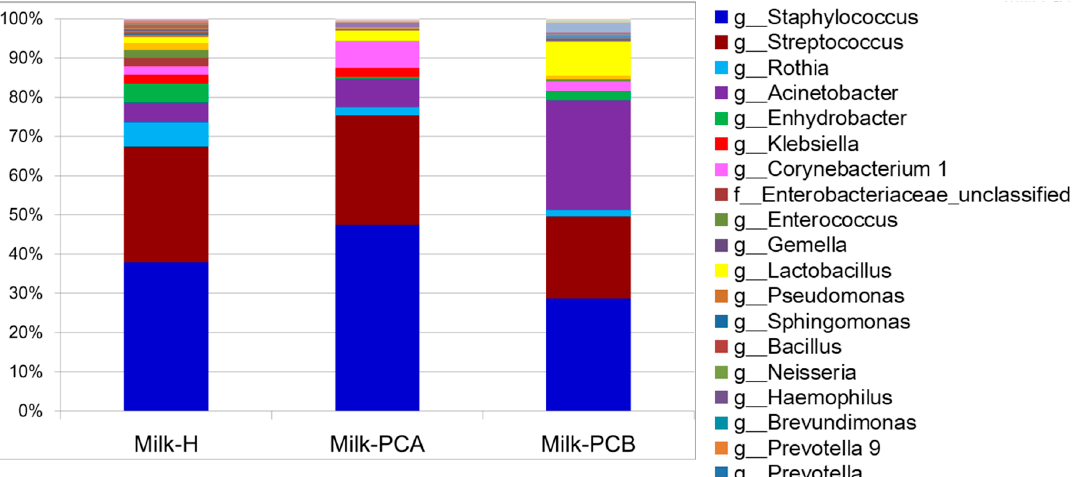
Figure 1. Proportions of major bacterial genus between two “doing-the-month” and one “non-doing- the-month” milk groups. Milk samples were collected from postpartum mothers who had completed the practice of “doing-the-month” (postpartum caring) for 20 to 30 days in postpartum care center A (milk-PCA, n = 14) or B (milk-PCB, n = 27). The control milk samples were harvested from the postpartum mothers in hospital who did not conduct the “doing-the-month” (milk-H, n = 46). The relative abundance of all the bacterial genera in each milk sample was determined using 16S rRNA gene amplicon sequencing, and the results were plotted according to the different milk groups.